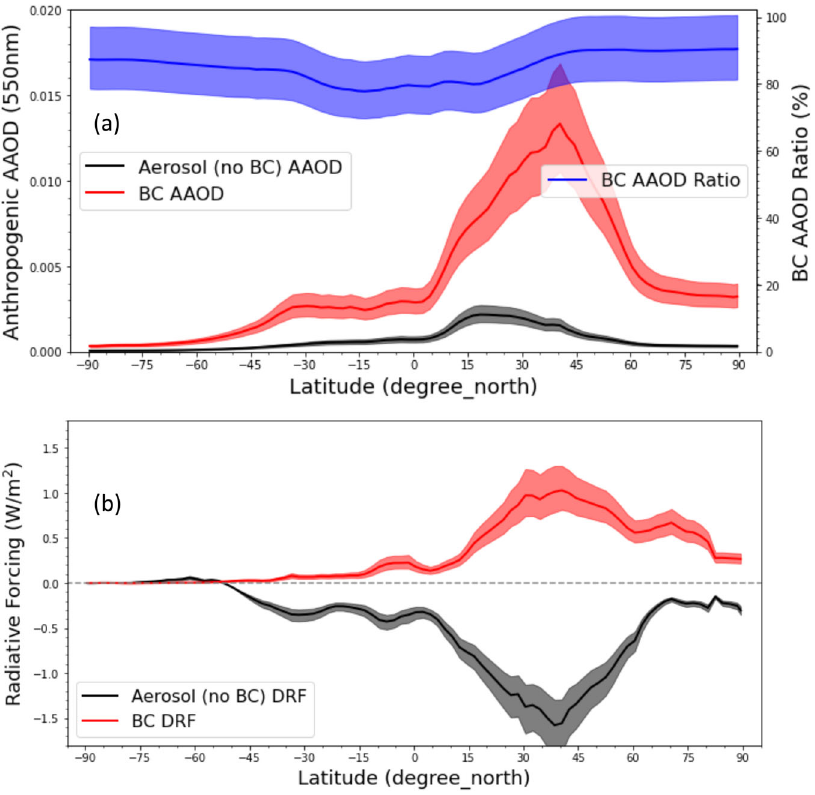
Fig. 3 | Latitude-dependent anthropogenic aerosol absorption and direct radiative forcing. a Zonal mean anthropogenic aerosol (no BC), BC absorption, and the fraction of anthropogenic aerosol absorption optical depth (AAOD)